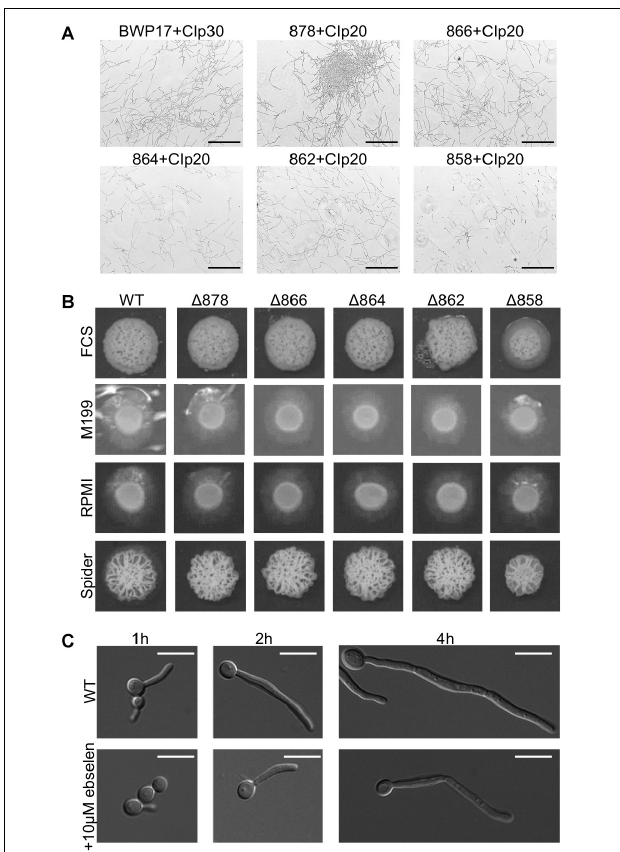
FIGURE 7 | Pma1p truncation affects filamentation capacity. (A) Cells were grown in liquid RPMI at 37 ◦ C, 200 rpm for 24 h and imaged via light microscopy. Increasing Pma1p truncation leads to the formation of fewer and shorter filaments than the wild-type control. Scale bars indicate 200 µ m. (B) Filamentation on hyphal-inducing agar plates. Three microliter OD-corrected cells from overnight cultures were spotted onto YPD+FCS, M199, RPMI, and Spider agar plates and incubated at 37 ◦ C for 5 days. Increasing Pma1p truncation leads to a modest defect in filamentation on FCS, M199, and RPMI agar plates. WT indicates the wild-type strain BWP17+CIp30. (C) Filamentation in the presence and absence of the Pma1p inhibitor ebselen at a concentration sub-inhibitory for growth. Cells were grown in liquid RPMI at 37 ◦ C for 24 h and imaged at select timepoints via light microscopy. Addition of 10 µ M ebselen to the growth media decreases hyphal length. Scale bars indicate 10 µ